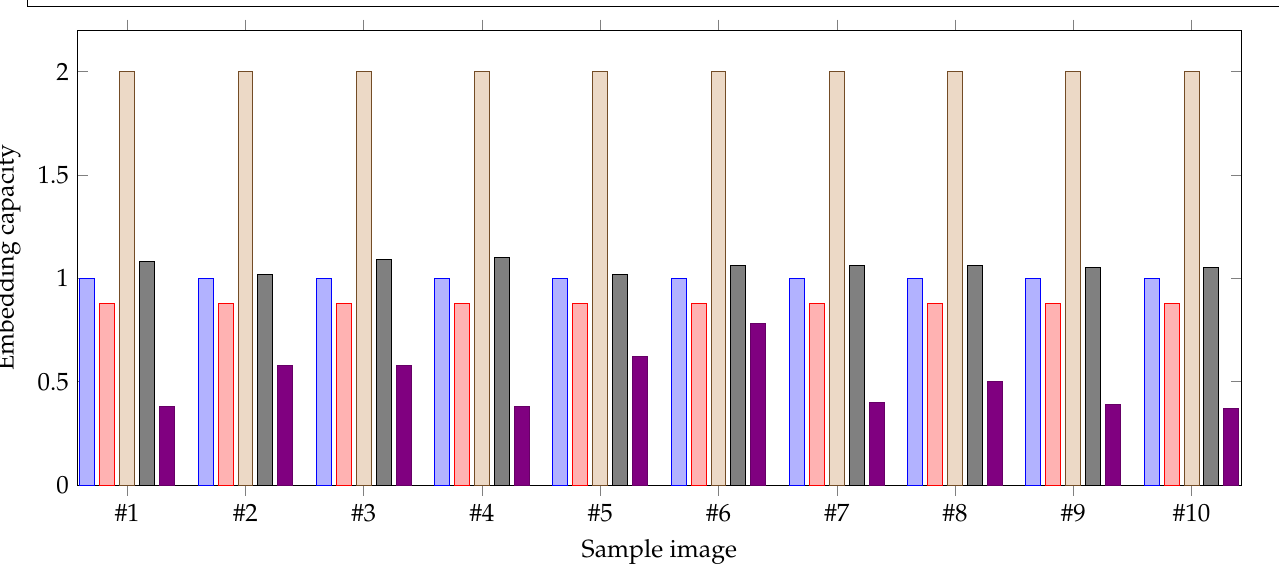
Figure 6. Embedding capacities of different images with respect to tempered pixels which are obtained by different schemes. The figure states that the proposed scheme has the third lowest embedding capacity due to implanting only edge pixels